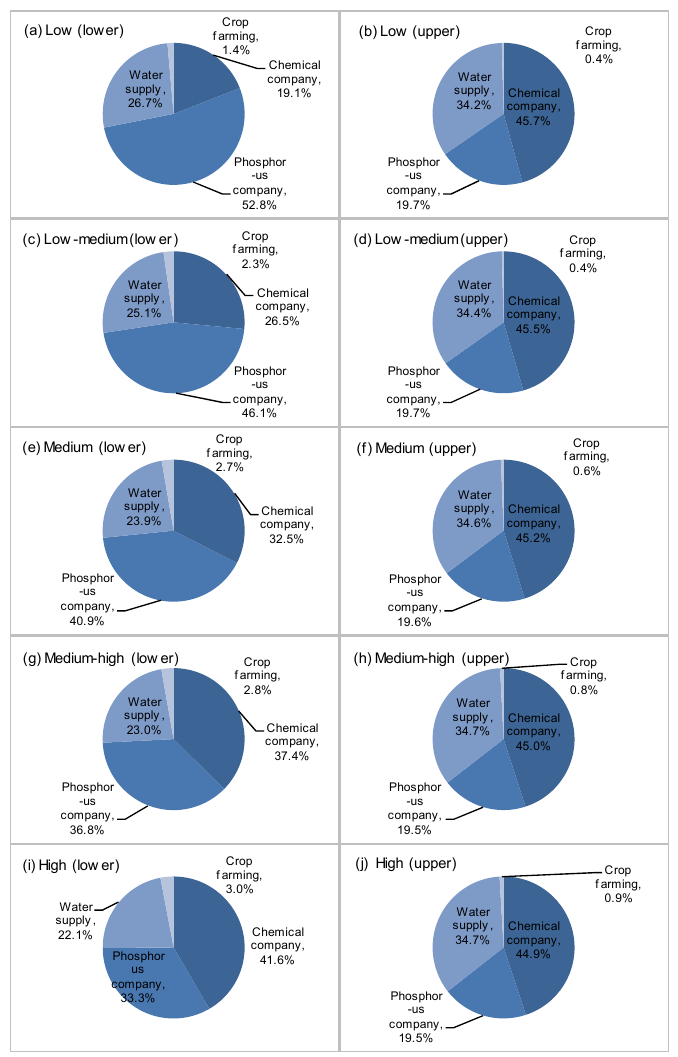
Figure 6. Proportion of benefit under different scenarios. ( a ) Lower bound under low scenario; ( b ) Upper bound under low scenario; ( c ) Lower bound under low ‐ medium scenario; ( d ) Upper bound under low ‐ medium scenario; ( e ) Lower bound under medium scenario; ( f ) Upper bound under medium scenario; ( g ) Lower bound under medium ‐ high scenario; ( h ) Upper bound under medium ‐ high scenario; ( i ) Lower bound under high scenario and ( j ) Upper bound under high scenario.